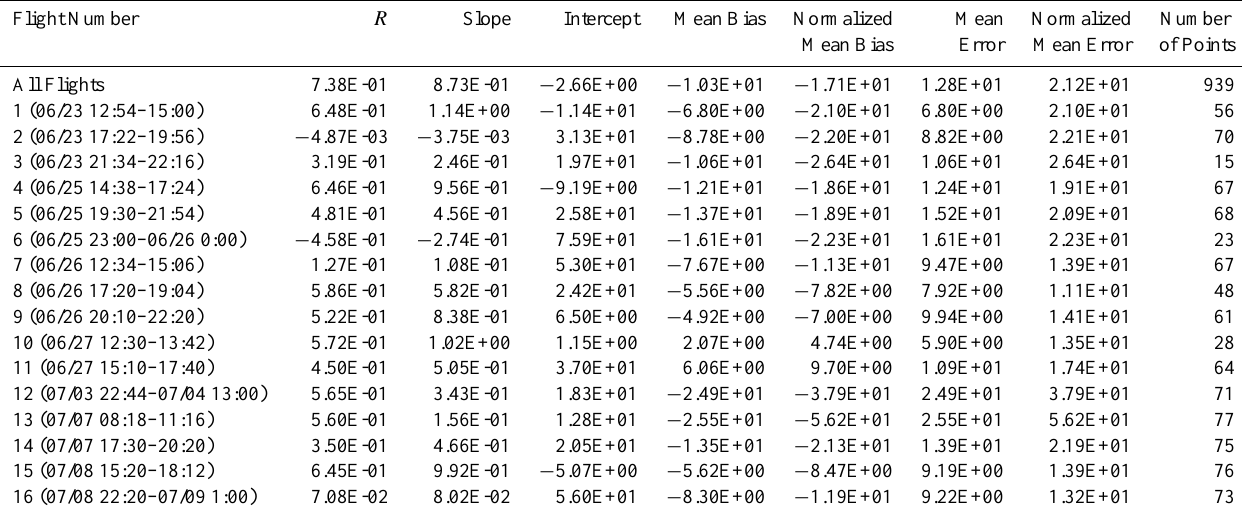
Table 3. Summary ozone statistics for aircraft flights.